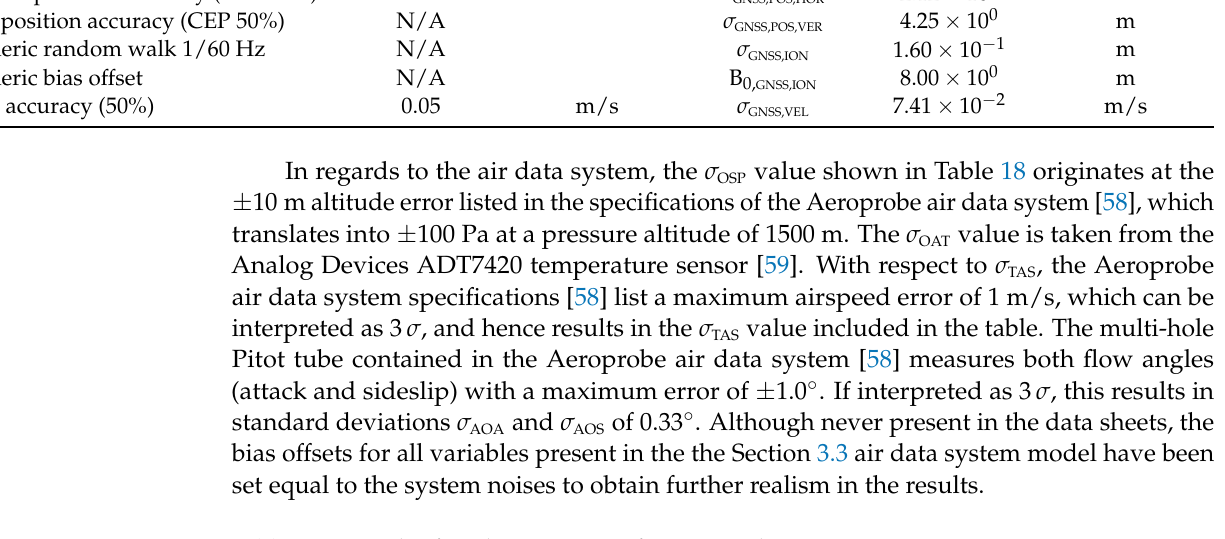
Table 18. Example of air data system performance values.